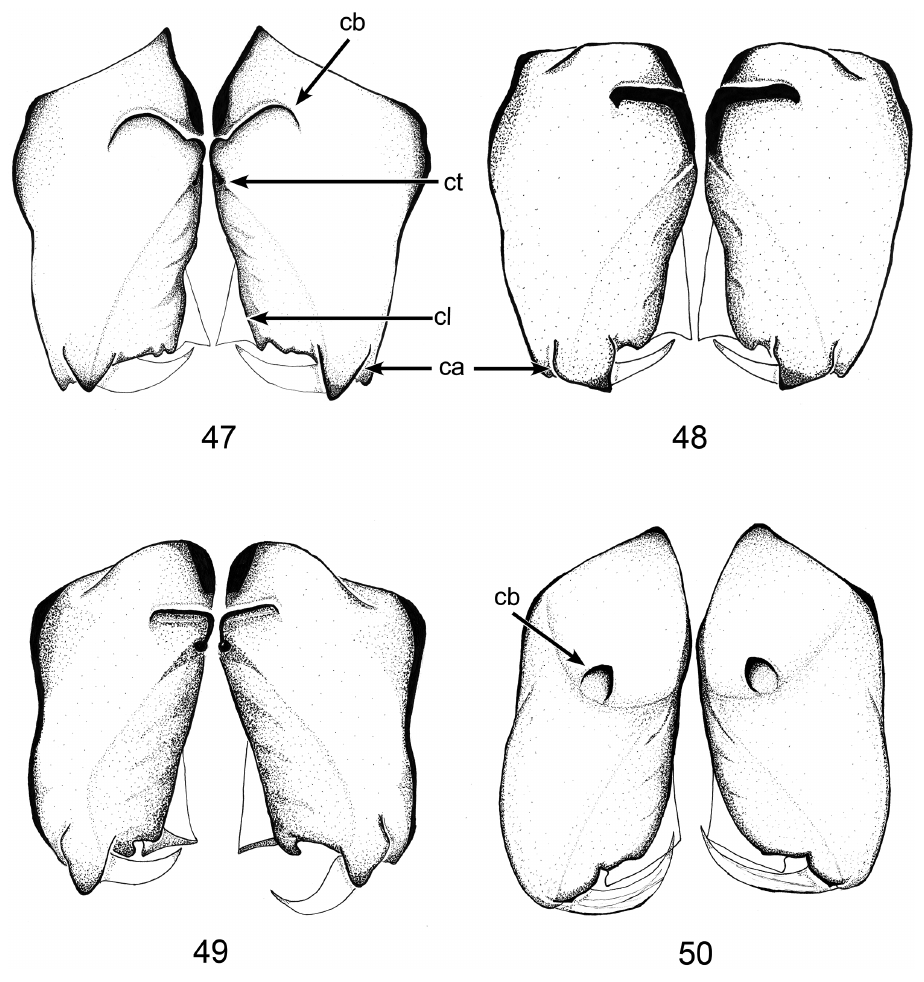
Figures 47–50. Male chelicerae, anterior views. 47 Ablemma andriana sp. n., A. contrita sp. n., A. kelinci sp. n., and Brignoliella patmae sp. n. 48 A. contrita sp. n. 49 A. kelinci sp. n. 50 Brignoliella patmae sp. n. Female (paratype) . Measurements: Total length: 1.14; carapace length: 0.56; cara- pace width: 0.52; abdomen length: 0.87; abdomen width: 0.70; clypeus height: 0.16. Length of legs: I 1.43 (0.49, 0.15, 0.32, 0.22, 0.25); II 1.37 (0.41, 0.16, 0.32, 0.24, 0.24); III 1.17 (0.32, 0.14, 0.26, 0.24, 0.21); 1.56 (0.46, 0.16, 0.39, 0.29, 0.26). Coloration: As in male. Carapace : Partly rugose, pars cepalica slightly rounded in lateral view; pars thoracica rugose, sloping gradually (Figs 41, 44); clypeus smooth, without clypeal horn, slightly rounded in lateral view (Fig. 44). Chelicerae : Cheliceral boss as small rounded projection. Eyes : 6 in 3 diads (Figs 41, 43). Abdomen : Dorsal scutum brownish orange, smooth (Fig. 41). Laterally with four pairs of stripe-like plates, brownish orange (Fig. 44). Ventrally covered by 4 scuta; pulmonary